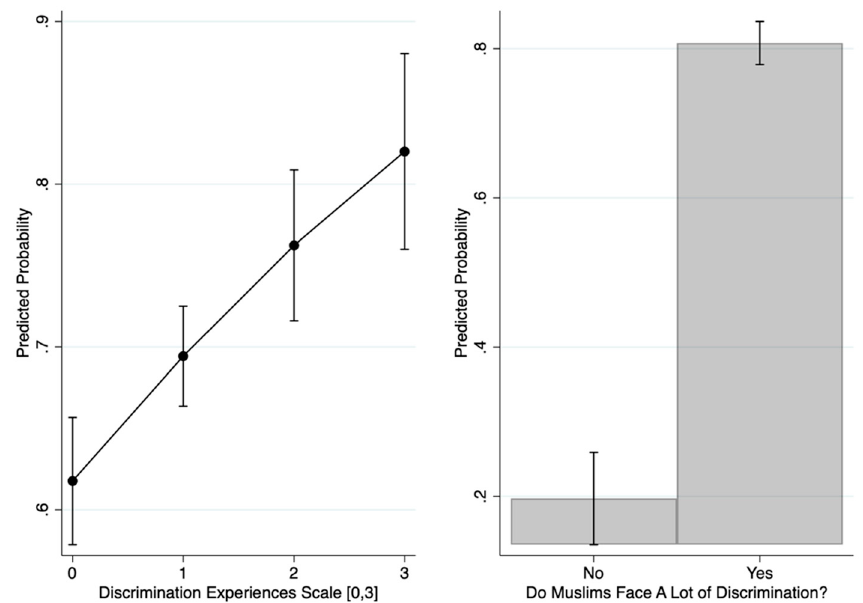
Figure 6. Predicted probability of perceiving discrimination against Hispanics, computed from models 3 (left) and 4 (right) of Table 4, which utilize 2017 data and include controls for age, gender, ethnicity, generation, income, mosque attendance, frequency of prayer, and political ideology.